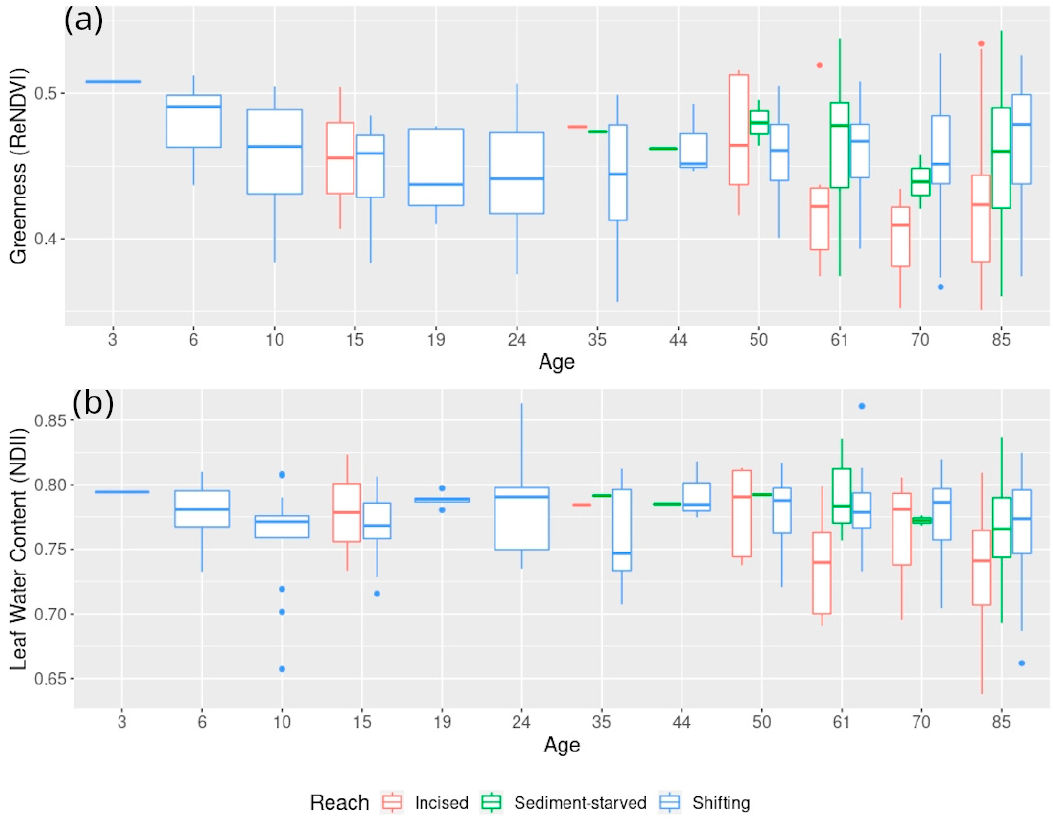
Figure 11. Greenness ( a ) and Leaf Water Content ( b ) indexes, according to the age of forest plots and their geomorphic reach. Table 7. Class error for each of the four random forest classifiers, according to the data used in the classifier–LiDAR and/or hyperspectral (HS). For each class, 50 plots were used to train the